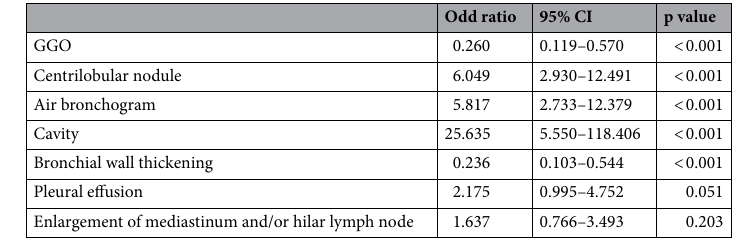
Table 4. Multivariate analysis for the identification of pulmonary tuberculosis among elderly patients with CAP based on HRCT features. CI confidence interval, GGO ground-glass